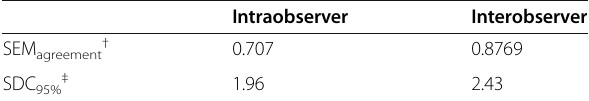
Table 3 Intra- and interobserver agreement